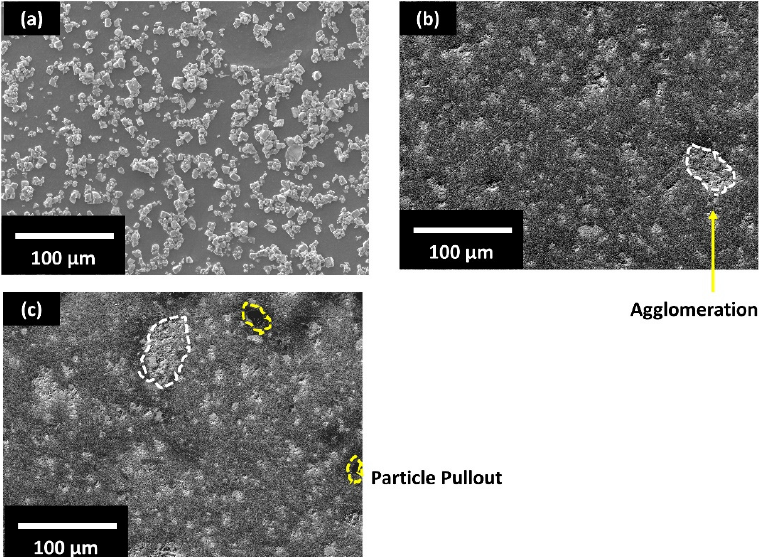
Figure 2. Scanning electron microscopy (SEM) image of: ( a ): KNLN (K 0.485 Na 0.485 La 0.03 NbO 3 ) powder; ( b ) horizontal cross section of the filament containing polylactic acid (PLA)-10 vol.% KNLN composite; ( c ) vertical cross section of the filament of PLA-10 vol.% KNLN composite (horizontal); white circles indicate agglomeration while yellow circles indicate particle pull-out.